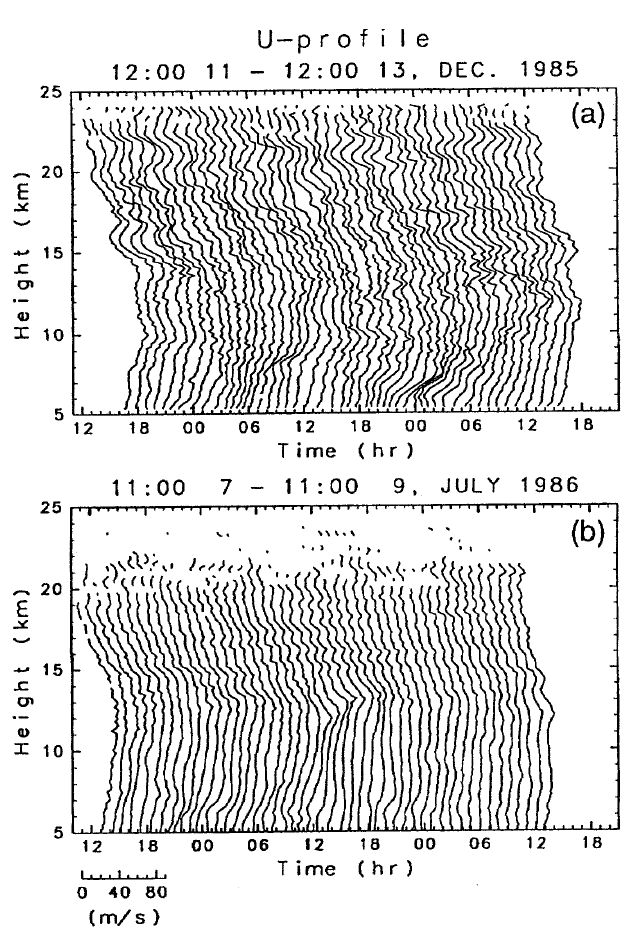
Fig. 13a, b. Time series of 1-h averaged vertical profiles of the horizontal wind component U observed with the MU radar a in winter, and b in summer (from Sato, 1994, Copyright